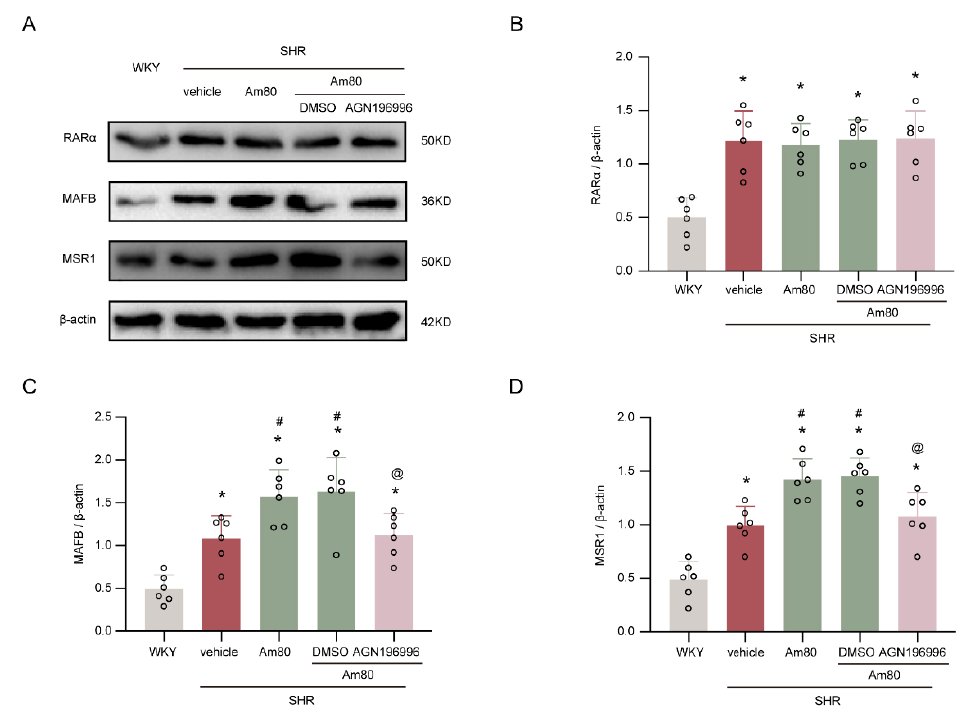
Figure 5. Am80 stimulated RAR α to reduce CSF hypersecretion via the MAFB/MSR1 pathway. ( A ) Representative Western blotting images of RAR α , MAFB, and MSR1 at week 7. ( B – D ) Quantitative analyses of RARα, MAFB, and MSR1 at week 7 ( n = 6). * p < 0.05 versus WKY rats at week 7, # p < 0.05 vs. SHR + vehicle group, @ p < 0.05 vs. SHR + Am80 + DMSO group. Values are means ± SD.